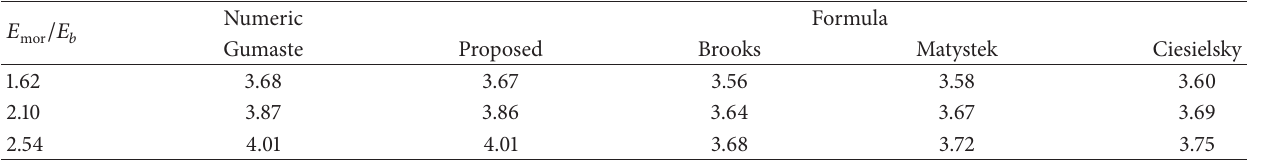
Table 8: Comparison of equivalent elastic moduli based on Gumaste data ( 𝐸 mor > 𝐸 𝑏 ). Numeric Formula 𝐸 /𝐸 mor 𝑏 Gumaste